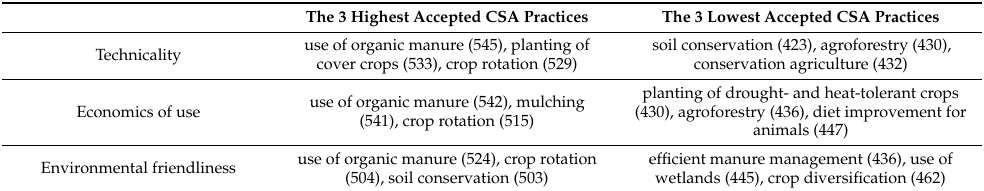
Table 1. Farmers’ perception on the acceptance of the compatibility dimensions of the different CSA practices (Author’s composition based on